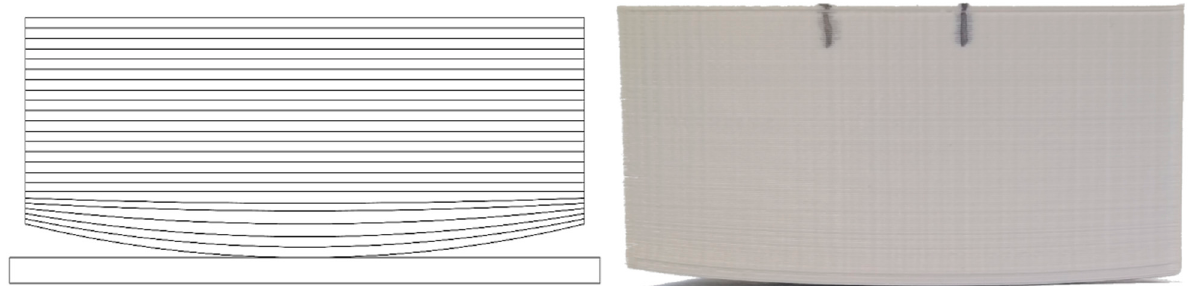
Figure 2. Warping. ( Left ): schematic drawing shows all layers. ( Right ): photo of a real printout.